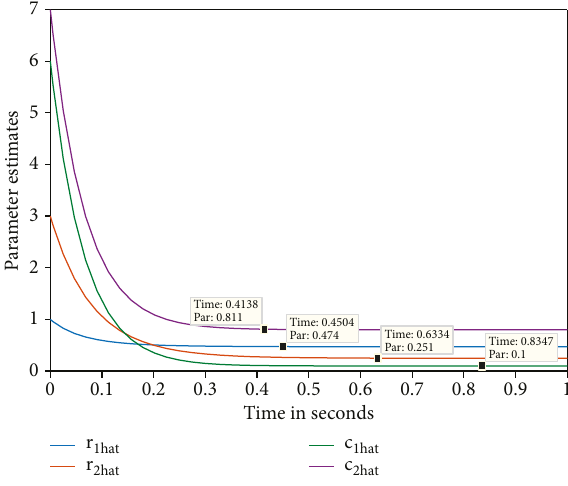
Figure 6: Time history of parameter